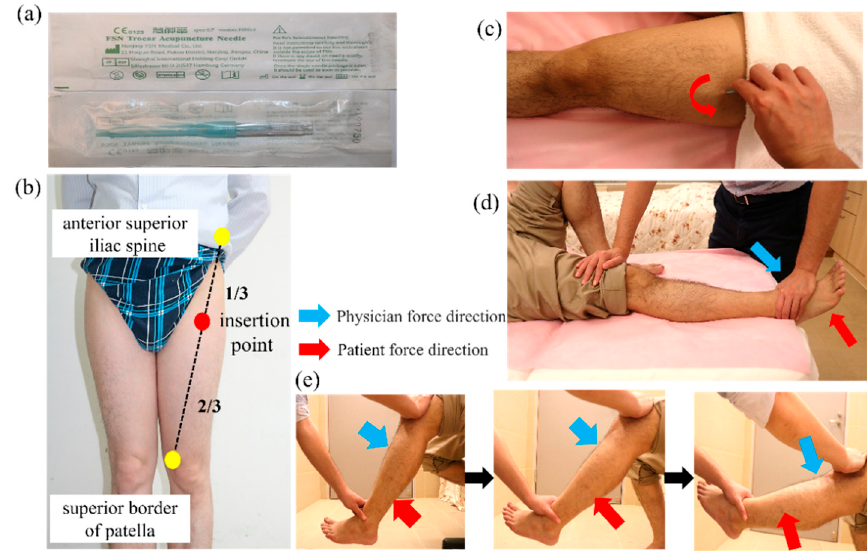
Figure 1. Illustration of the operations of Fu’s subcutaneous needling. FSN was performed as described in the Materials and Methods. ( a ) FSN needle. ( b ) Insertion point of FSN insertion. ( c ) Starting a swaying movement. ( d ) Dorsiflexion of the foot and resistance towards the practitioner in the reperfusion approach. ( e ) Knee extension and physician’s resistance in the reperfusion approach.